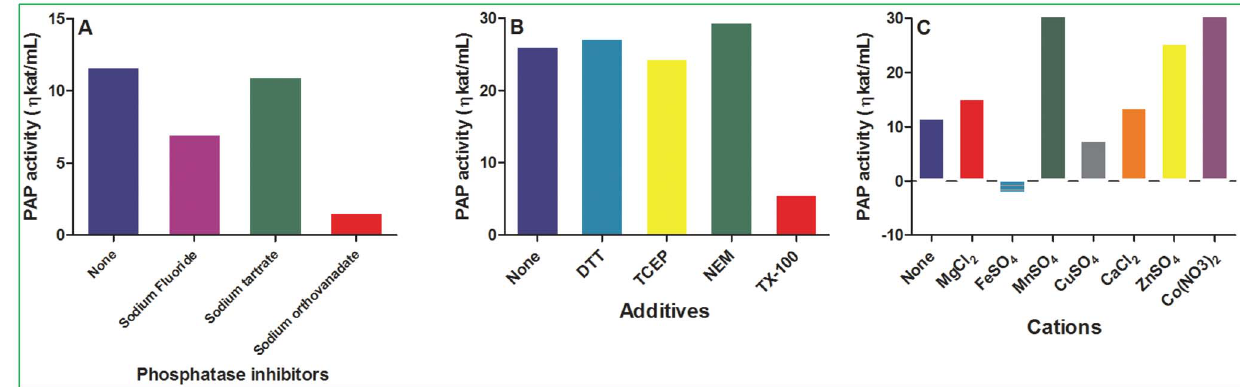
Figure 7. Effects of phosphatase inhibitors, additives and cations on PAP activity. The assays were performed at 53 u C, pH 6.5 for 10 min using 5 m L of the PAP preparation with 500 m M DPA. (A) Effect of phosphatase inhibitors on PAP activity. The phosphatase inhibitors used were NaF (1 mM), sodium tartrate (4 mM) and sodium orthovanadate (2 mM). (B) Effect of additives on PAP activity. The final concentration of each additive in the assay buffer was 100 mM, except TX-100 was used at 10% concentration. (C) Effect of cations on PAP activity. The final concentration of each cation in the assay buffer was 0.3 mM. The data presented are the mean of 2 assays for each sample.